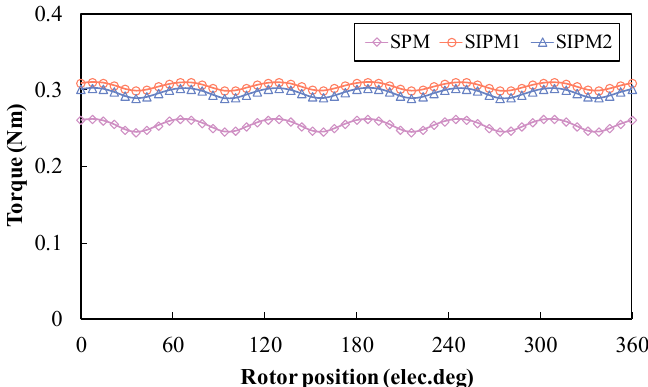
Figure 11. Output torque.